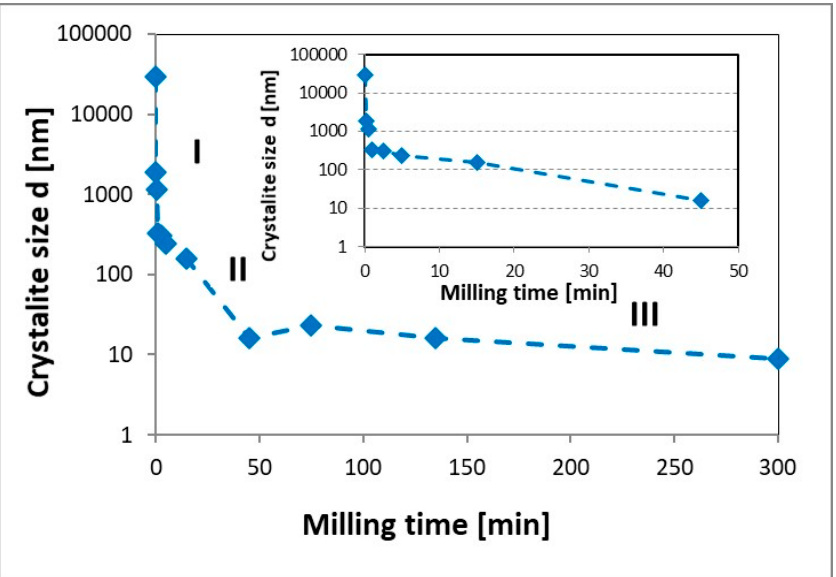
Figure 3. The changes in the crystallite size for as-received and milled MgH 2 .